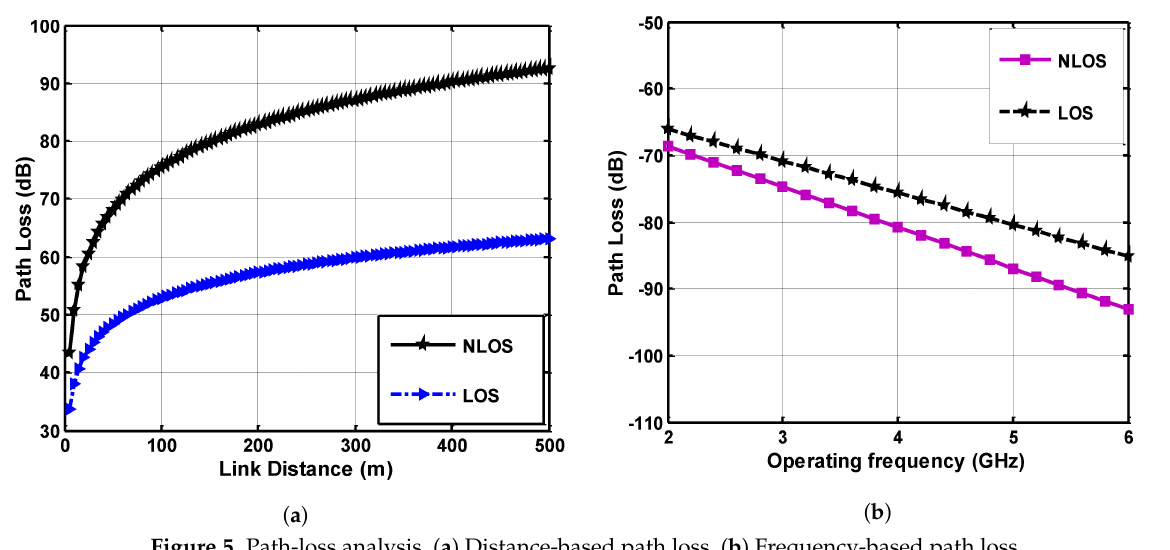
Figure 5. Path-loss analysis, ( a ) Distance-based path loss, ( b ) Frequency-based path loss.